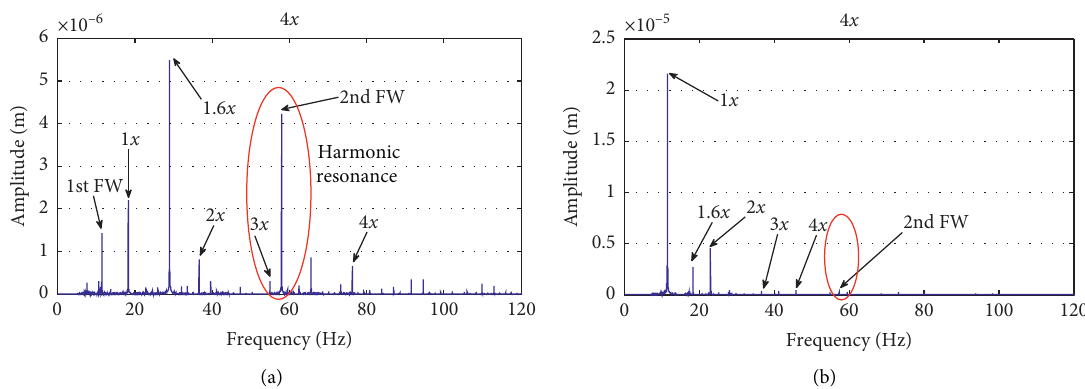
Figure 27: Spectrum of misalignment and unbalance in bearing 4. (a) horizontal ( Ω Ω 2 � 17.6Hz).